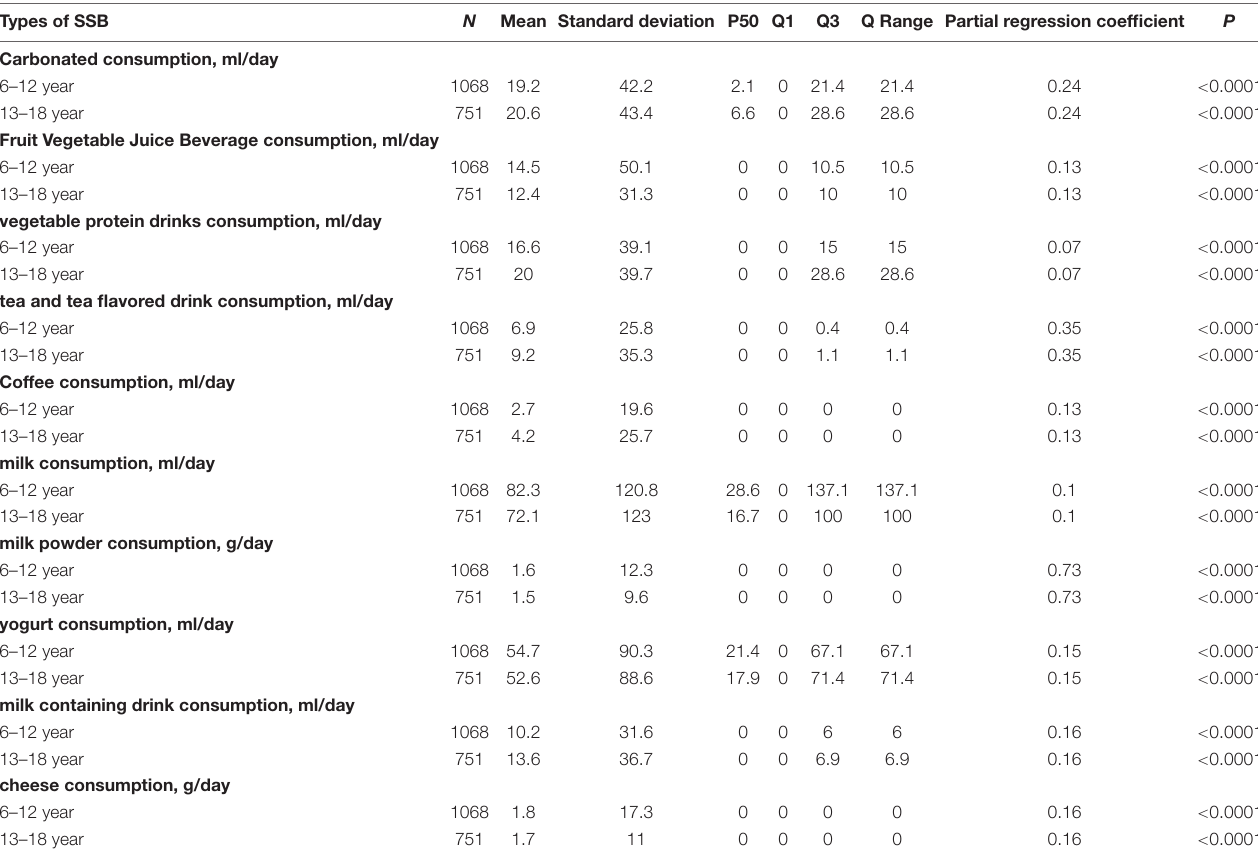
TABLE 4 | Relationships between sugar intake from SSB and different types of beverage consumption among 6–18 years in Shandong, China. Types of SSB